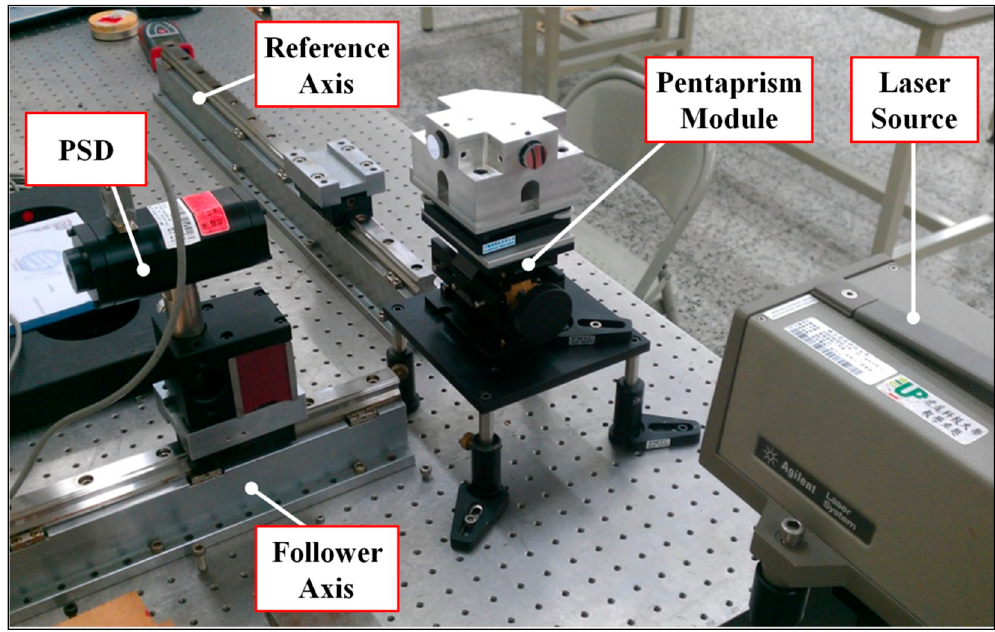
Figure 17. Verification setup of perpendicularity measurement using the proposed system.